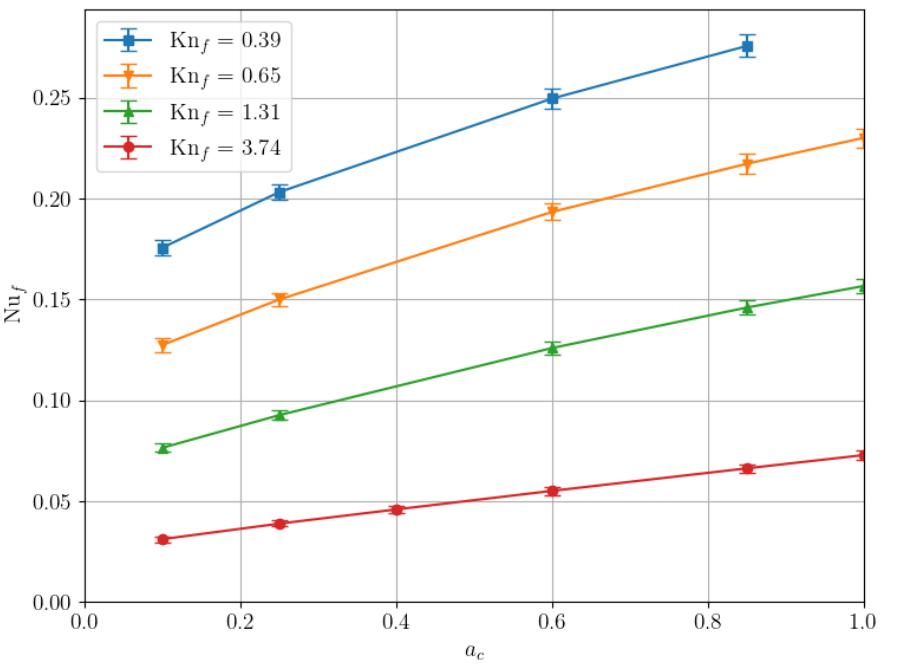
Figure 8. Dependence of wire heat transfer on surface accommodation coefficient at different values of wire Knudsen number. Data shown correspond to U ∞ = 3 m/s. Error bars indicate ± 1 σ of the steady-state DSMC